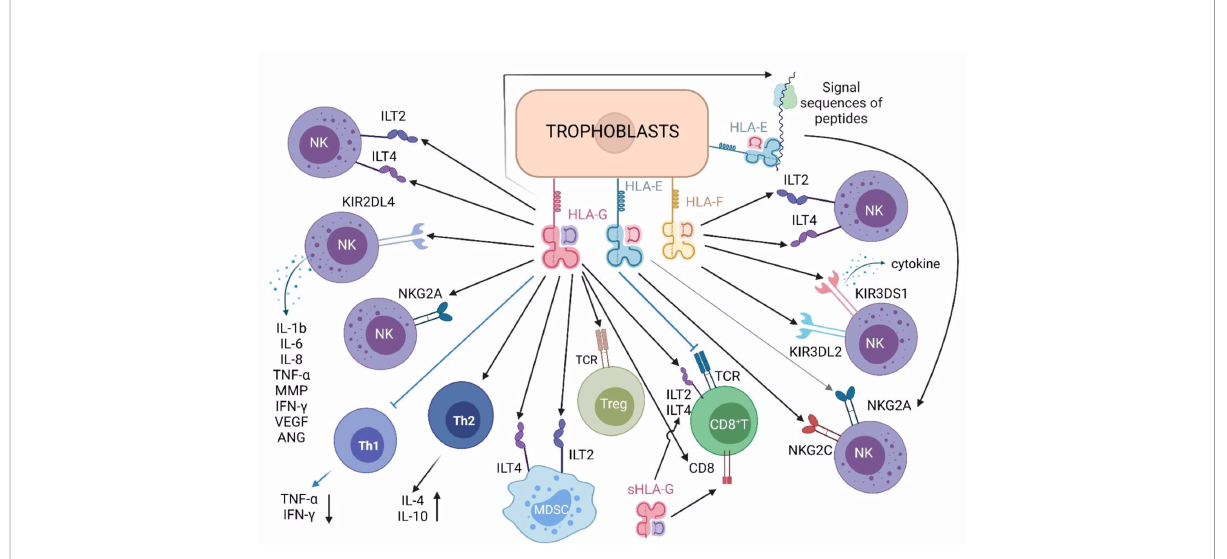
FIGURE 2 Roles of HLA class Ib molecules in immune cells in maternal decidua.